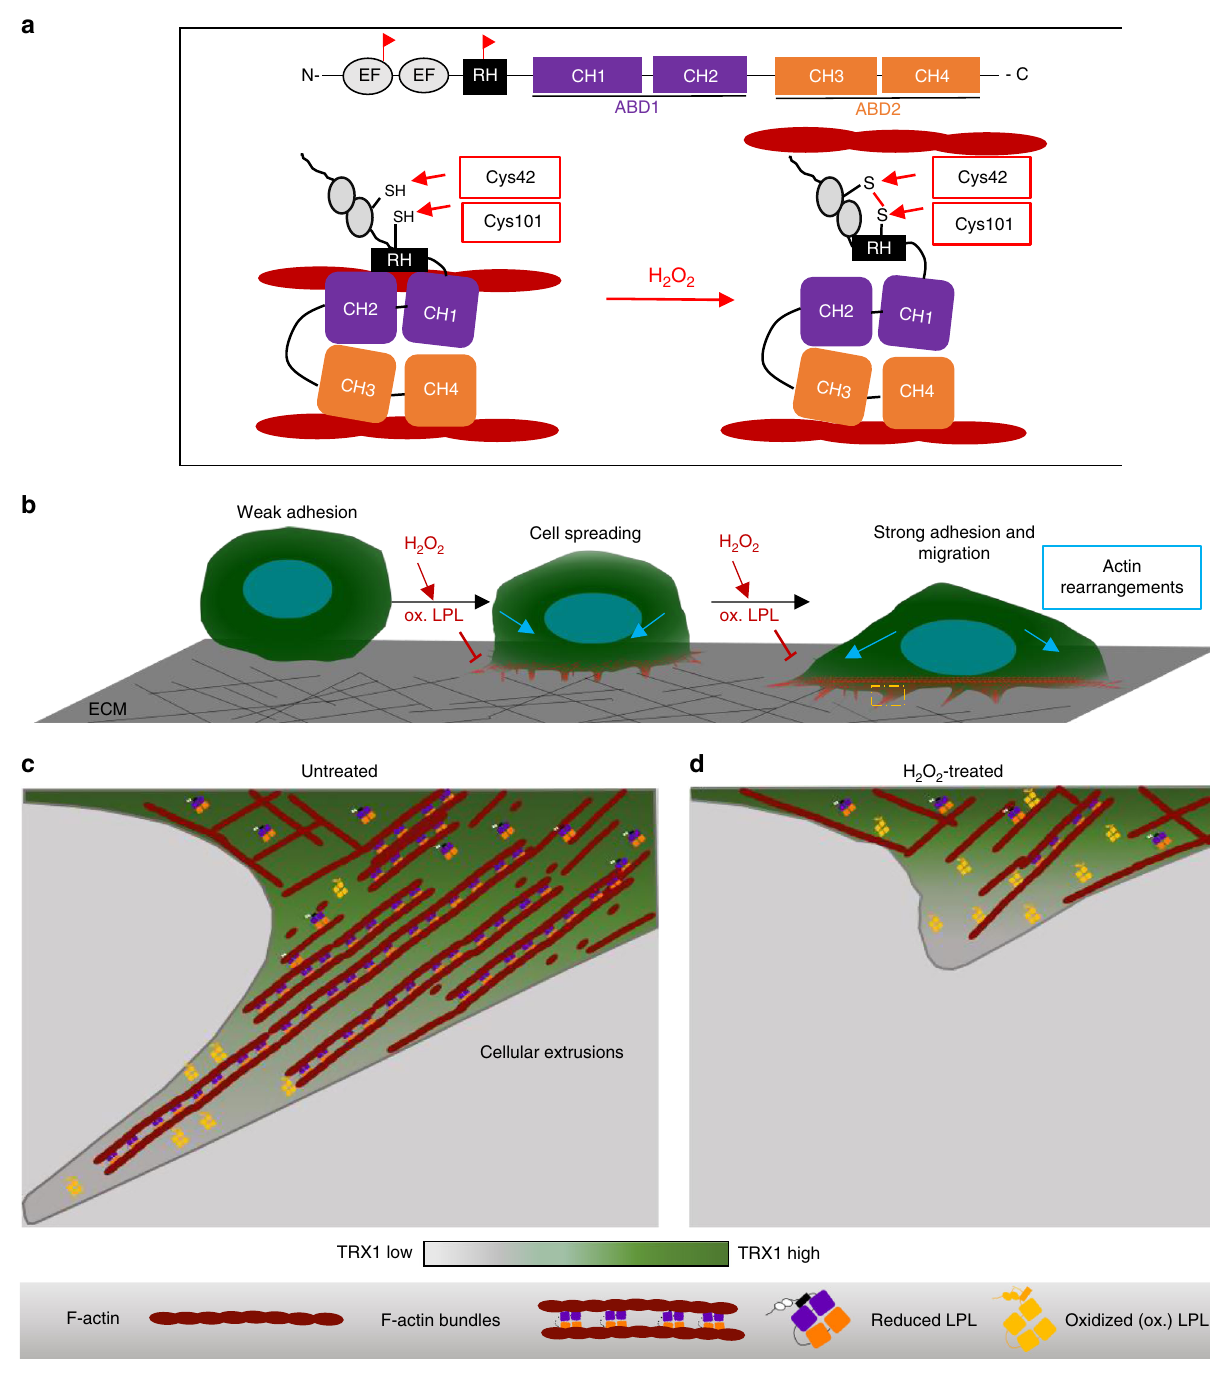
Fig. 9 Proposed models: a the redox regulation of the actin-bundling function of LPL and b – d the regulation of peripheral actin dynamics by spatial oxidation of LPL. a LPL bundles F-actin by sequential binding of ABD1 and ABD2 to adjacent actin fi laments. The regulatory helix (RH) domain folds onto ABD2. H 2 O 2 treatment leads to disul fi de bridge formation between Cys101 (located at the RH) and Cys42 (located at the EF-hand module), thereby leading to dissociation of ABD2 or less ef fi cient binding of ABD2 to F-actin. Red colored fl ags show the location of Cys42 and Cys101 on LPL. b Cell spreading through peripheral actin dynamics is halted by H 2 O 2 treatment. After weak adherence, cells spread by forming actin-based cellular extrusions. Administration of exogenous ROS blocks cellular extrusion formation and cell spreading. c, d Enlarged cartoon of the boxed region in b . c Under control conditions, actin bundling by reduced LPL is involved in the formation of cellular extensions. d Under pro-oxidative conditions, the formation of actin bundles by LPL is prevented, impeding the formation of cellular extrusions. The color scale from light to dark green indicates the concentration gradient of TRX1. In the absence of antioxidant systems at such rapidly forming structures, the likelihood of protein oxidation is